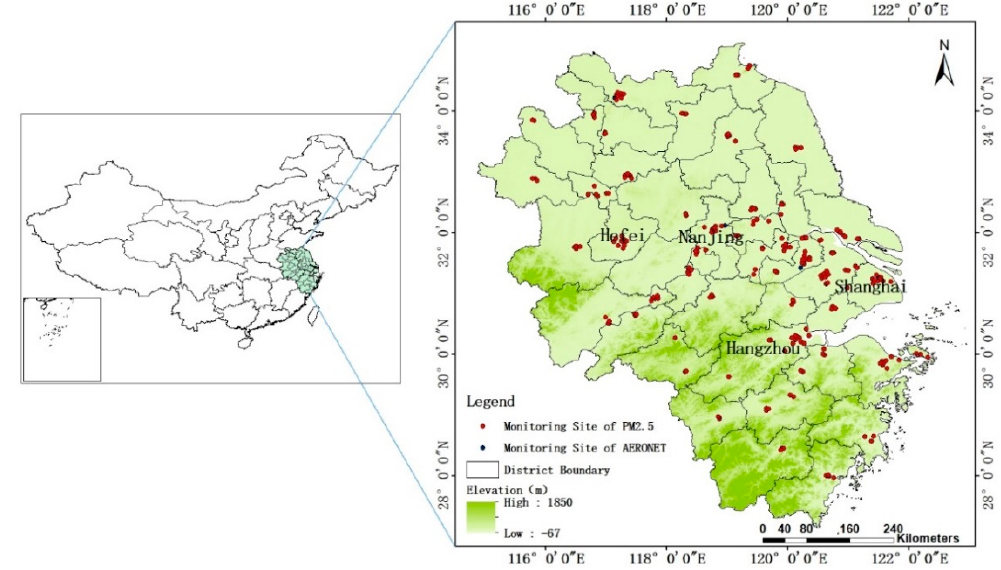
Figure 1. Study area and distribution of ground-level PM 2.5 and AERONET monitoring sites.